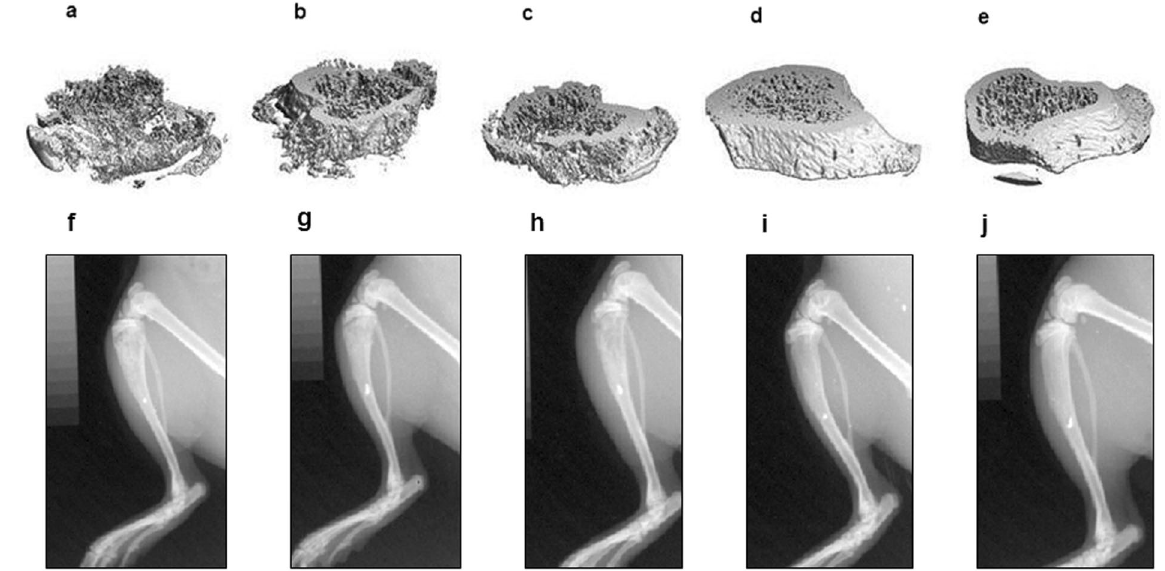
Figure 4. Micro-CT and x-ray images illustrating the proximal part of the tibia of the five different treatment groups. Micro CT image captured post-mortem of ( a ) cancer-operated and treated with vehicle; ( b ) Cancer- operated and treated with 5 mg/kg dasatinib; ( c ) Cancer-operated and treated with 15 mg/kg dasatinib; ( d ) Sham-operated and treated with vehicle; and ( e ) Sham-operated and treated with 15 mg/kg dasatinib. X-ray images captured on day 22 post inoculation f) cancer-operated and treated with vehicle; ( g ) Cancer-operated and treated with 5 mg/kg dasatinib; ( h ) Cancer-operated and treated with 15 mg/kg dasatinib; ( i ) Sham- operated and treated with vehicle; and ( j ) Sham-operated and treated with 15 mg/kg dasatinib.